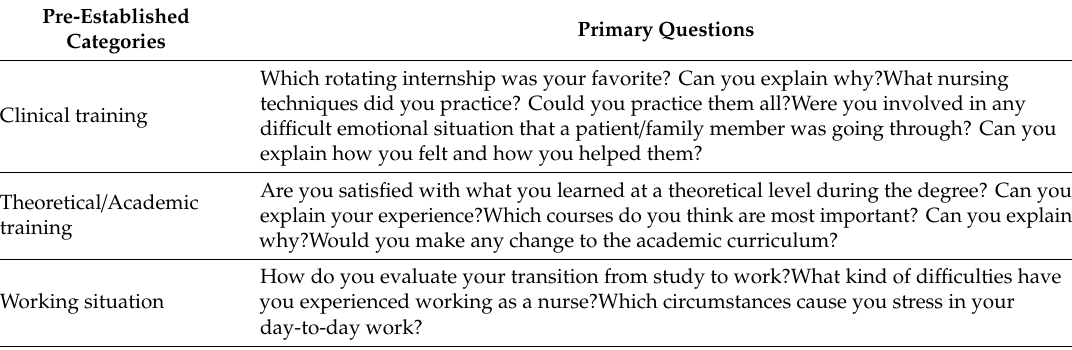
Table 2. Primary questions of the interview guide.